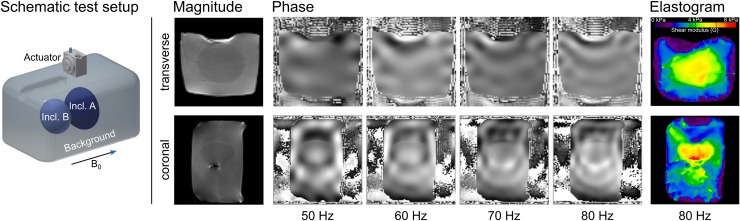
Results of 3 T MRE measurements.Left: Schematic drawing of the phantom used for image acquisition at 3 T. Inclusion A, corresponding to the elasticity of a bladder, is shown in dark blue. Inclusion B, corresponding to the elasticity of a prostate, is depicted in light blue. The actuator was placed on top of the phantom. Middle: Magnitude and phase images. Some trapped air is visible between the inclusions and the background material yielding to artifacts. Phase images were obtained for frequencies ranging between 50 Hz and 80 Hz. Right: Elastograms reconstructed at 80 Hz. Top row is a transverse slice showing inclusion A, Bottom row displays a coronal slice with both inclusions.